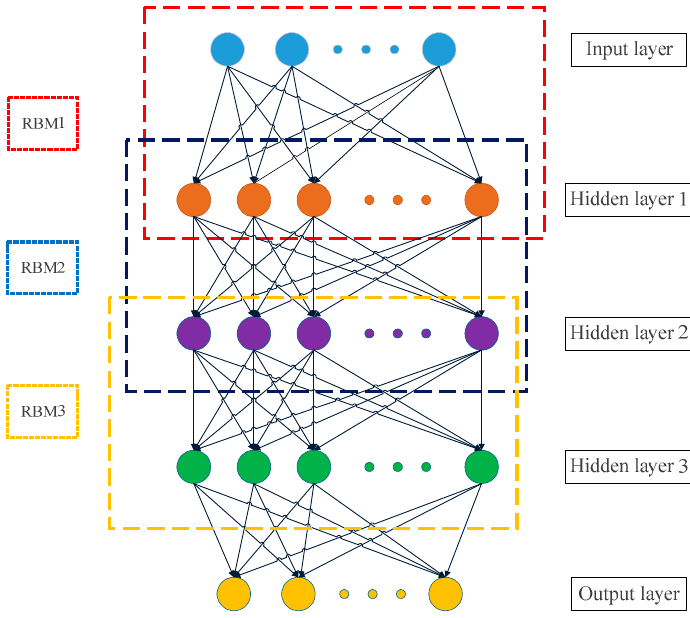
Figure 3. Schematic diagram of the deep belief network (DBN).